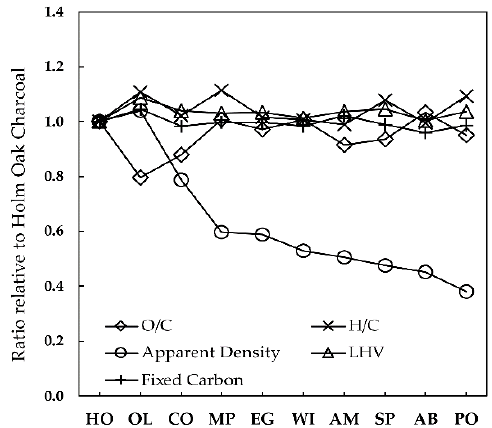
Figure 5. Ratios of charcoal properties obtained from distinct wood types in relation to those of holm oak charcoal. Wood abbreviations according to legend in Figure 2.